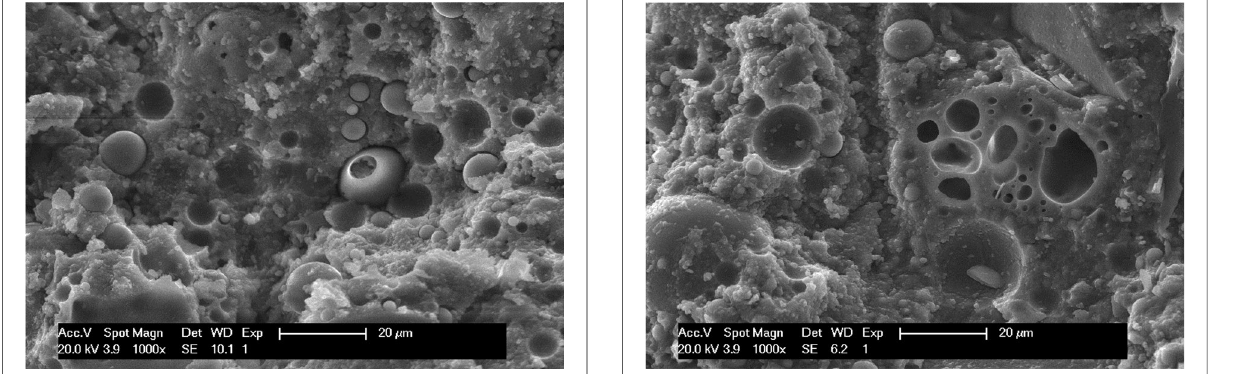
Fig. 6 Microstructure of M-FA(HCC)-2 cured at 20 °C after 28 days. Fig. 7 Microstructure of M-FA(HCC)-2 cured at 38 °C after 28 days.